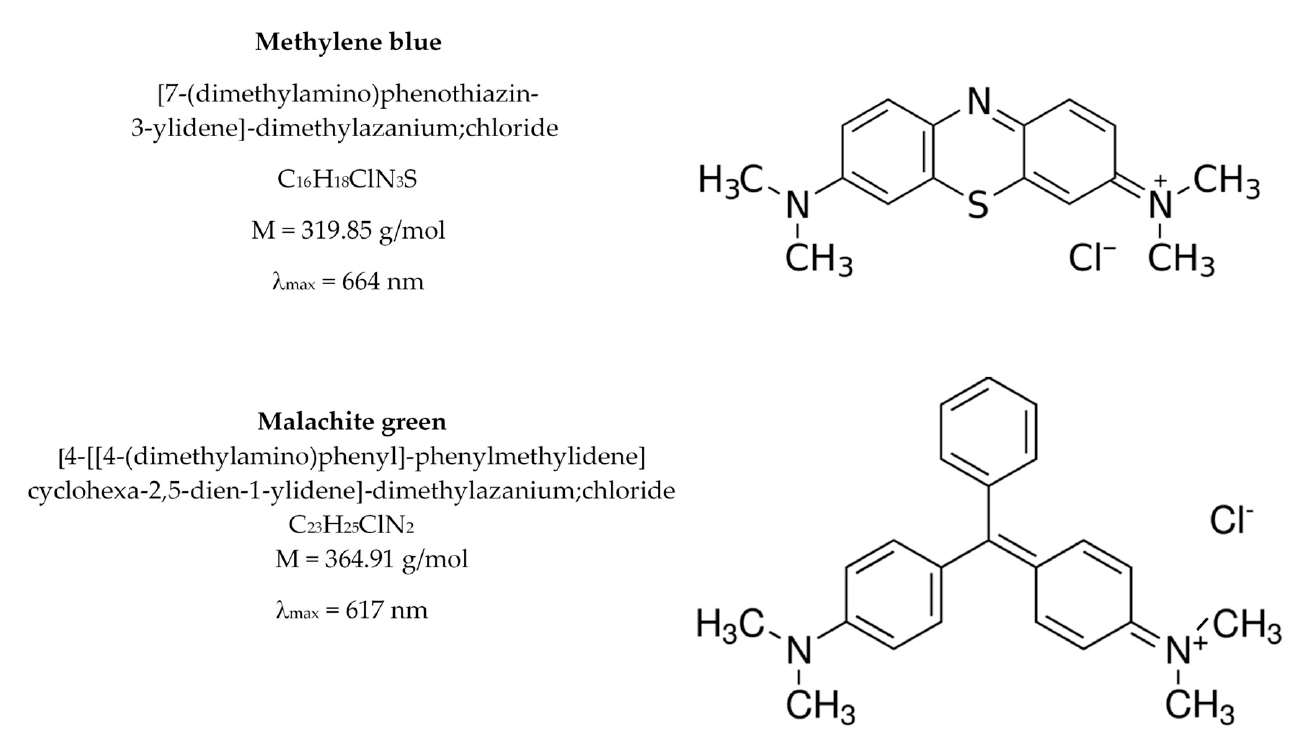
Figure 2. Organic synthetic dyes used during adsorption tests.